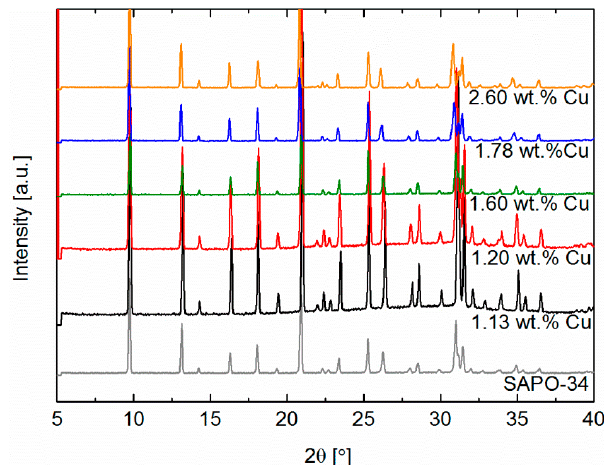
Figure 1. X-ray diffractograms (XRDs) of SAPO-34 and Cu/SAPO-34 with different Cu loadings.